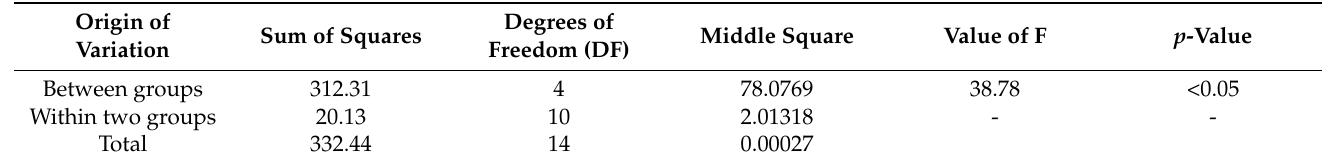
Table 7. Results of variance analysis (ANOVA) performed to evaluate the effect of moisture of membranes with copaiba oil content on the chitosan matrix.